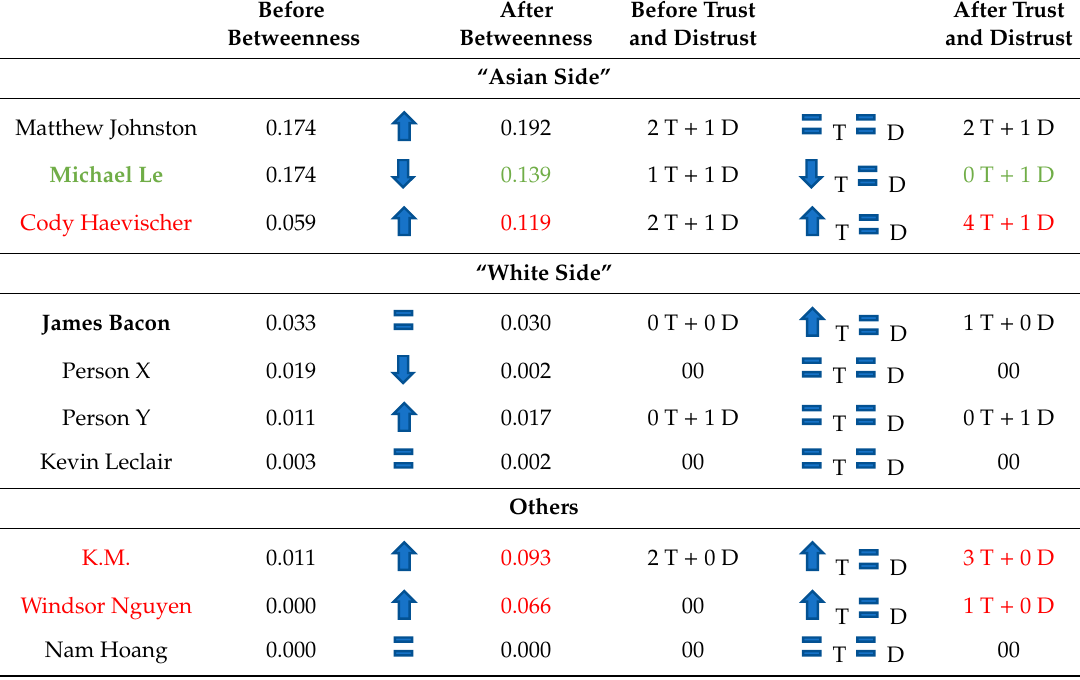
Table 1. Comparison of network structures before and after the Surrey Six Murder. Before the Murder